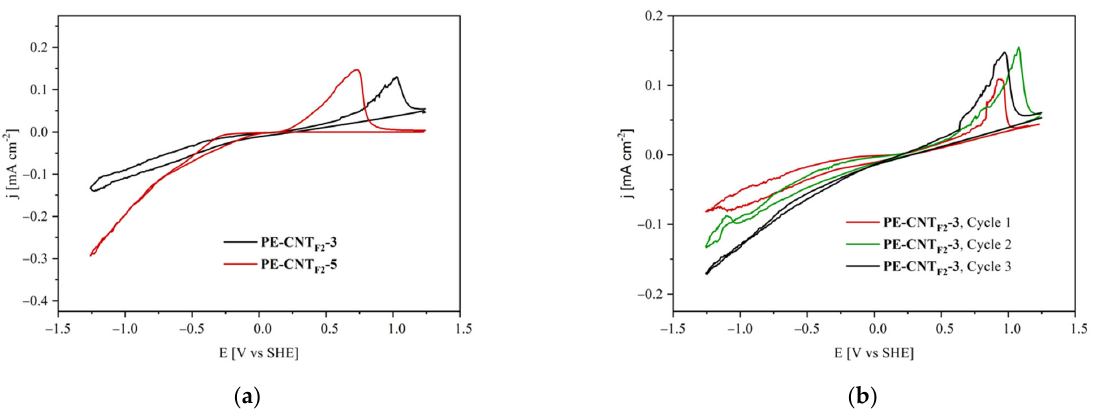
Figure 6. Cyclic voltammograms of PE ‐ CNT F2 ‐ 3 and PE ‐ CNT F2 ‐ 5 composites ( a ) and three consecutive runs operated on a PE ‐ CNT F2 ‐ 3 sample ( b ).